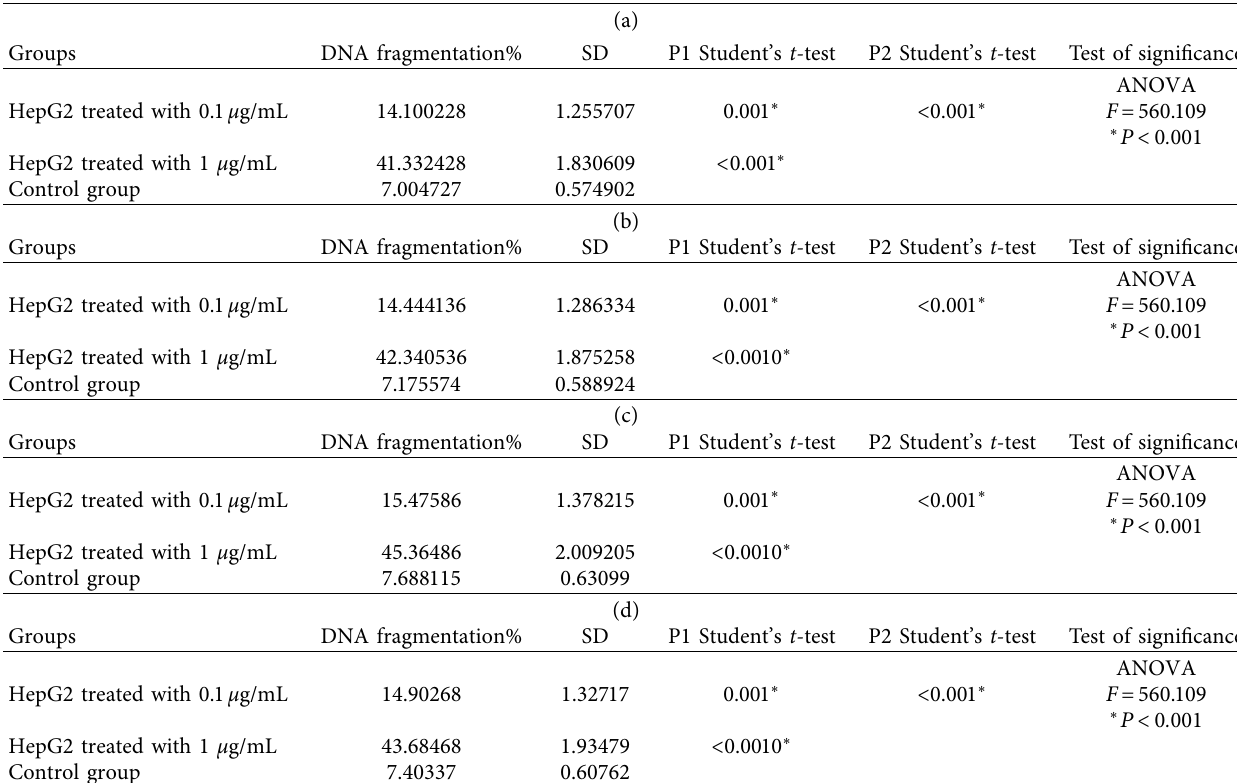
Table 8: DNA fragmentation of (a) azo ligand and its (b) Cu(II), (c) Co(II), and (d) Fe(II) complexes at (0.1, 1 μ g/mL) on HepG2 cells.